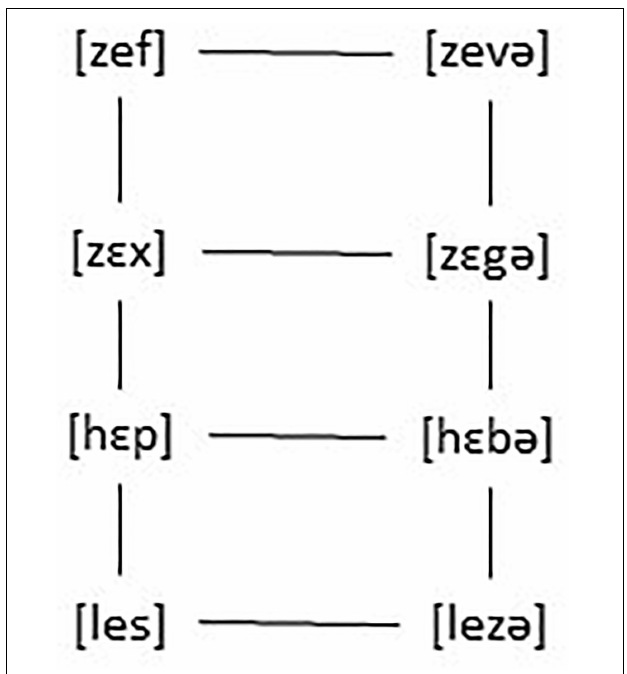
FIGURE 5 | A cloud of tokens and relations between